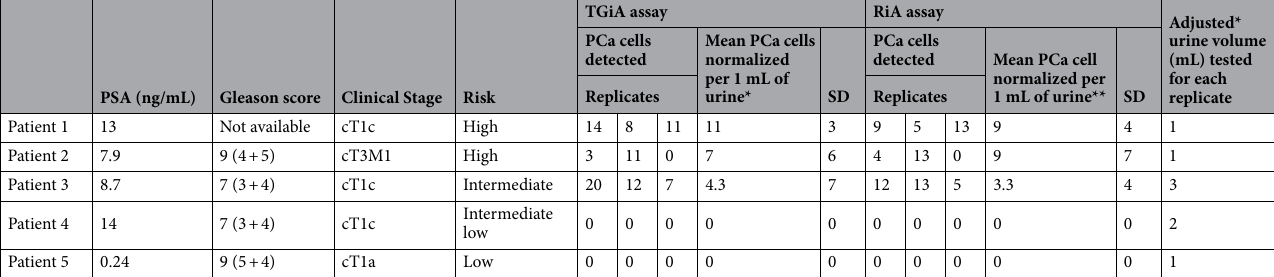
Table 1. Clinical data of patients including PSA, Gleason score, clinical stage and clinician based judgement of risk. The number of PCa cells detected by TGiA and RiA assays of three replicates of patients’ urine samples. OSAM microscopy was used to count the number of cells labelled with the Eu-Probe, and Raman spectroscopic signals of the RiA were approximated based on linear equation obtained from the spiked cells in urine (Fig. S8B). *The adjusted volume of patients’ urine tested for each replicate are shown in the last right column. *The mean PCa cells detected by TGiA and RiA were normalised to